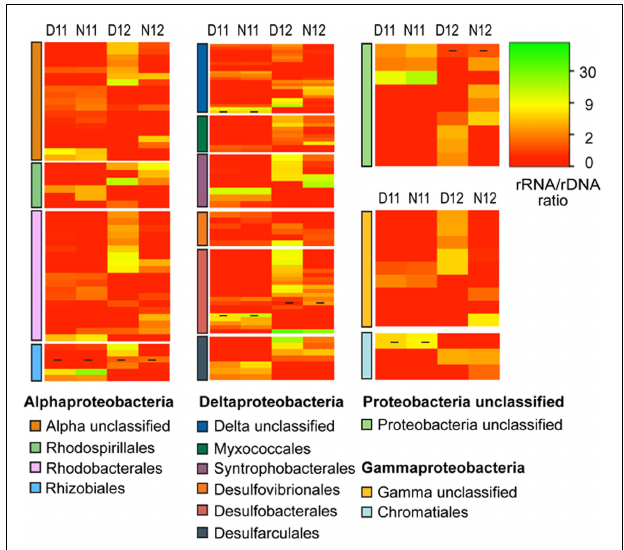
FIGURE 5 | Heatmap analysis of OTU PSP for each proteobacterial order for day and night samples across salinities (D11, Day 2011; N11, Night 2011; D12, Day 2012; N12 Night 2012). The heatmap color represents the extent of PSP as measured by rRNA: rDNA ratio within each OTU. Square colors shifted toward brighter green indicate higher PSP of that OTU. Dash within squares indicates abundant OTUs. Standard deviations are located in Supplemental Table